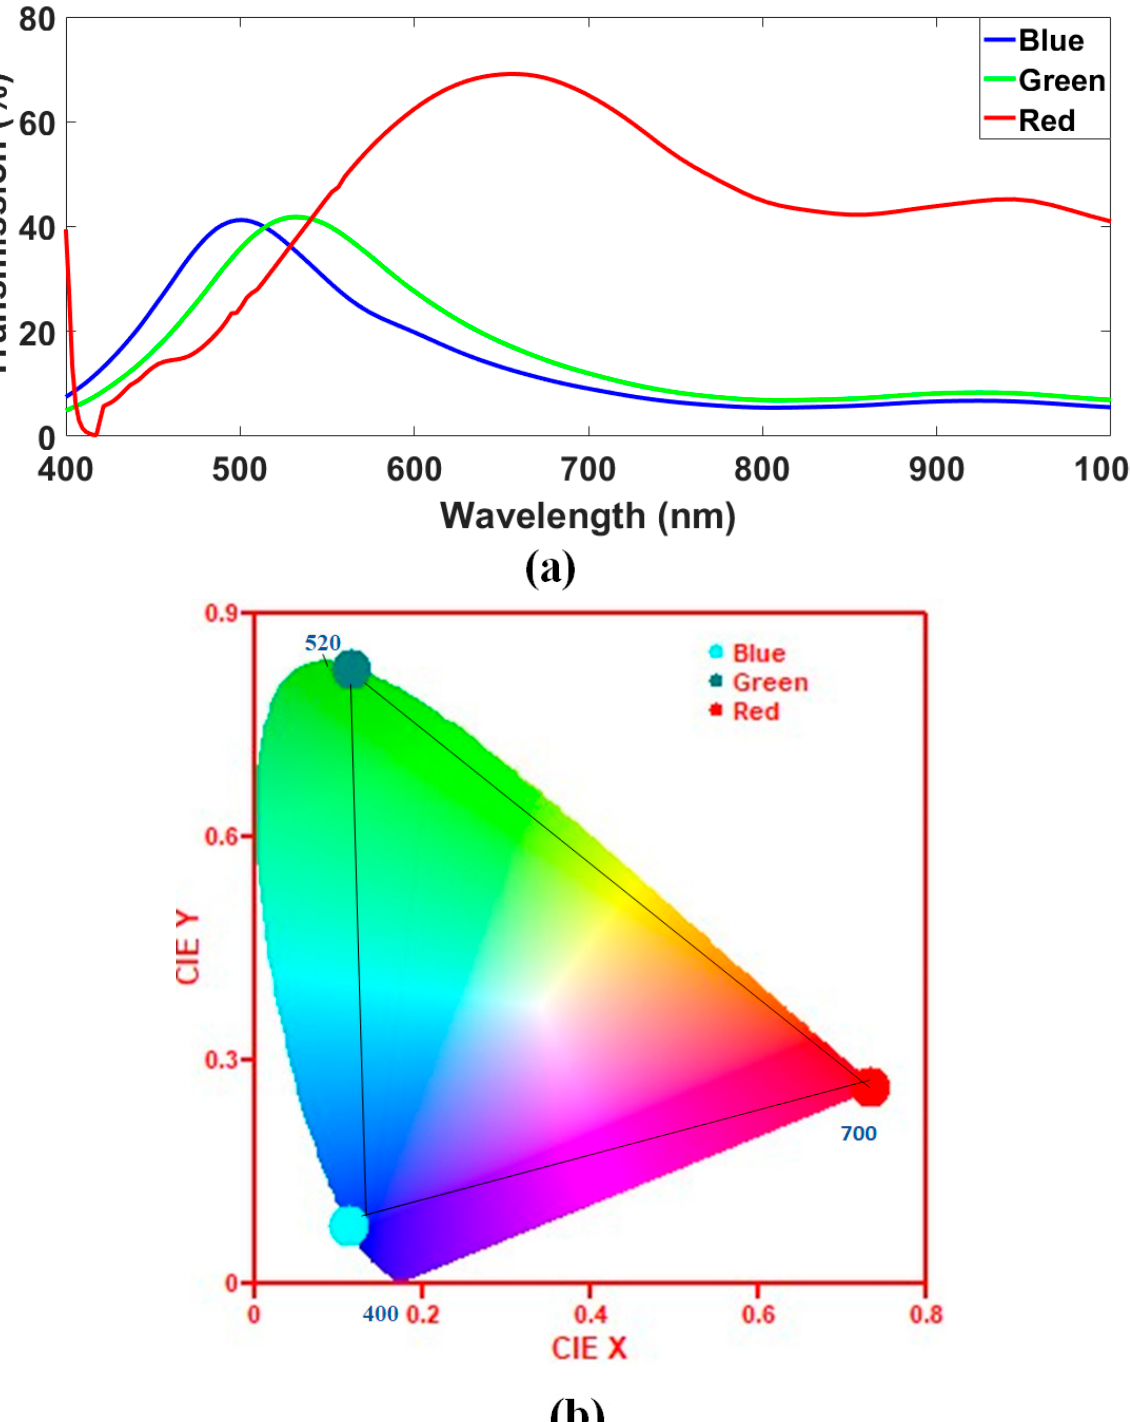
Figure 17. ( a ) Transmission spectrum of the structures that correspond to W1 = 85 nm, W2 = 55 nm, L1 = 190 nm, and L2 = 190 nm; the green-related structural parameters W1 = 70 nm, W2 = 60 nm, L1 and L2 = 210 nm; structures with red spectral lines in their structural characteristics W1 = 115 nm, W2 = 95 nm, L1 and L2 = 250 nm. ( b ) The CIE 1931 chromaticity diagram shows the color coordi-